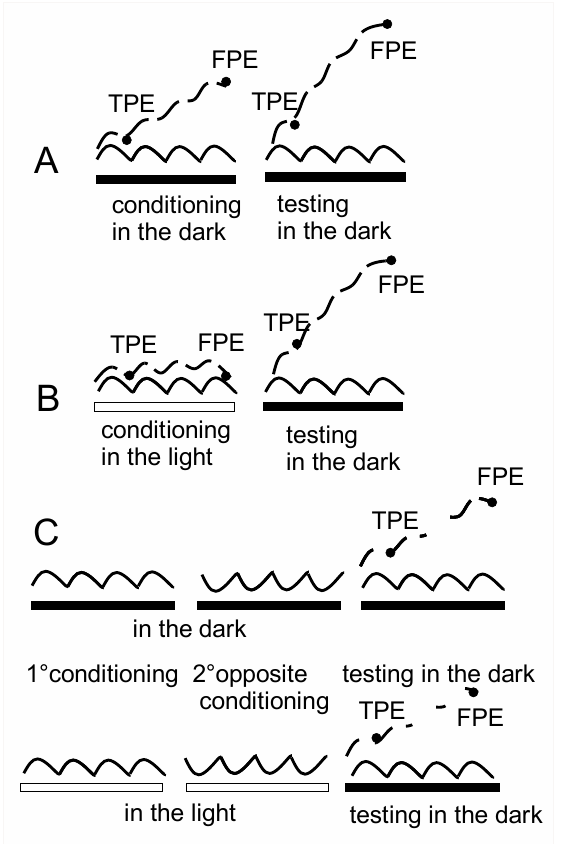
Figure 2. Stimulation procedure for conditioning and cancellation. ( A ) Four asymmetric cycles in the dark for conditioning followed by four asymmetric cycles in the dark for testing session 1; ( B ) four asymmetric cycles in the light for conditioning followed by four asymmetric cycles in the dark for testing; ( C ) four asymmetric cycles for conditioning plus opposite asymmetric cycles for cancellation and four asymmetric cycles for testing (same conditioning asymmetry). Solid line: asymmetric rotation; dashed line: perceptual tracking. Horizontal bar: white: light on; black: light off. Black spot on tracking trace after the first cycle indicates TPE and that at the end of the four cycles indicates FPE.